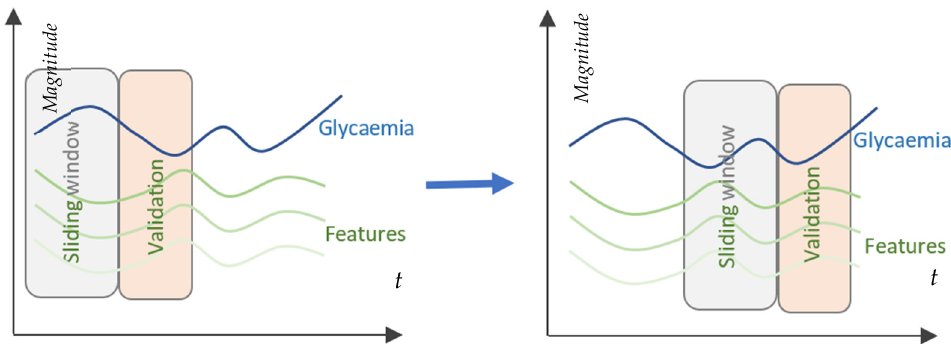
Figure 1. Cross-validation and time series analysis using a slide window.